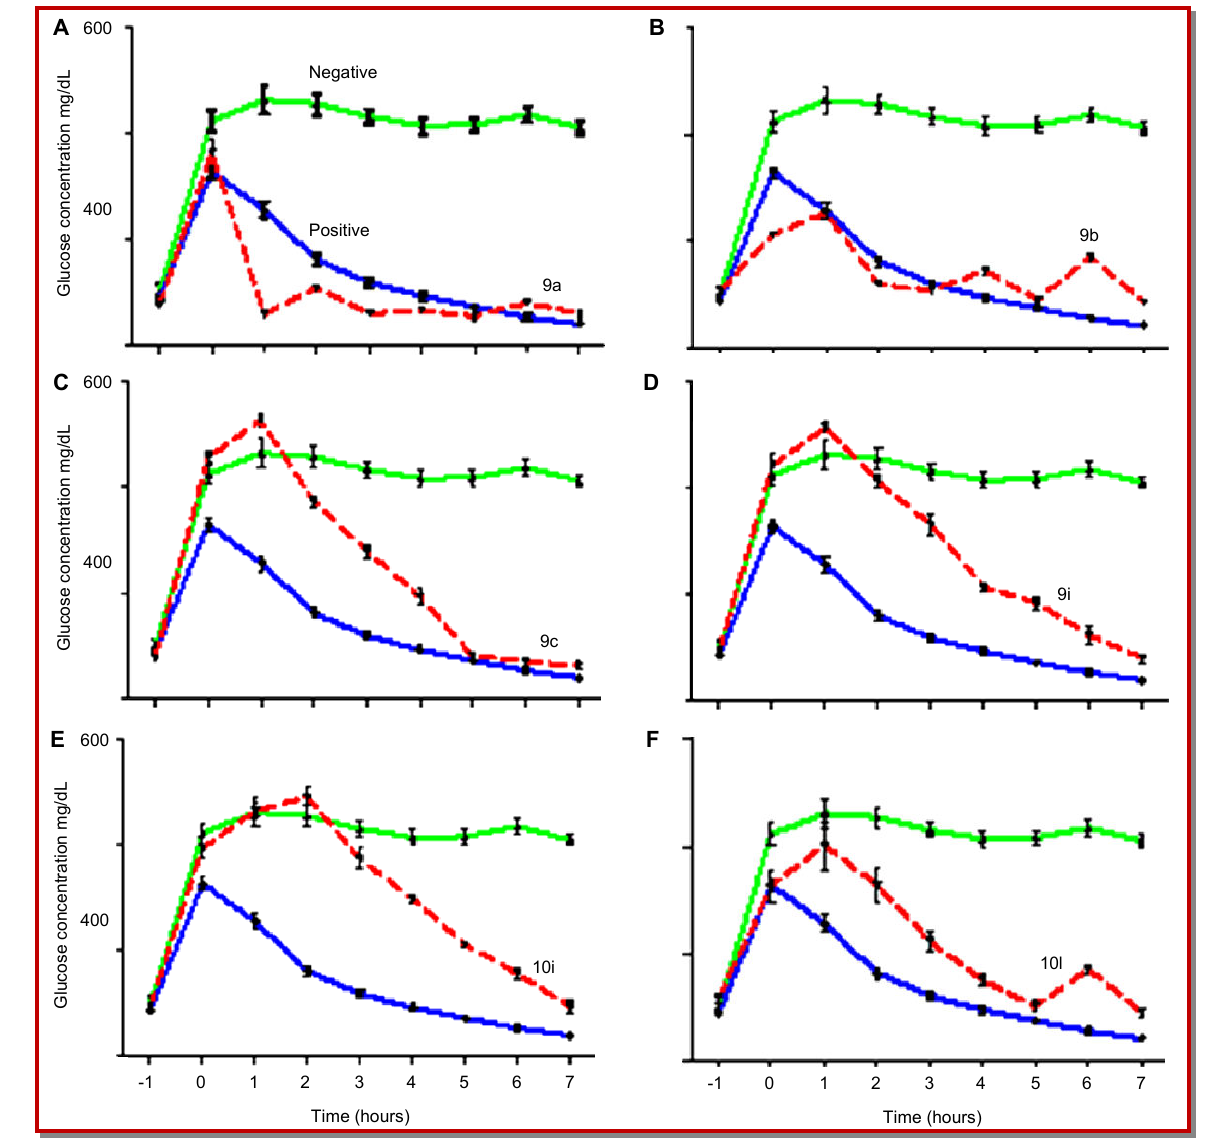
Figure 1: Plasma glucose concentration in mice treated with synthetic compounds (9a, 9b, 9c, 9i; 10i, 10l) positive control was treat- ed with glibenclamide while the negative control was alloxan only